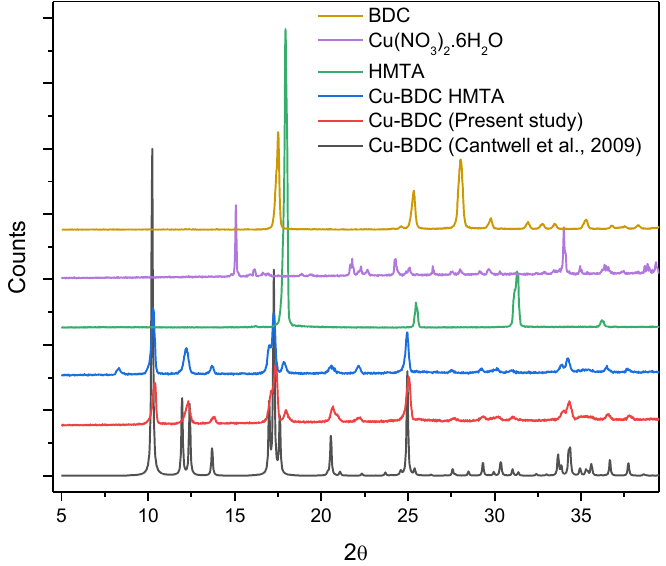
Figure 2. PXRD patterns for Cu-BDC (black, reported by Carson et al., 2009), Cu-BDC (red, synthesized herein), Cu-BDC ⊃ HMTA (blue), HMTA (green), Cu(NO 3 ) 2 · 6H 2 O (lilac) and the H 2 BDC linker (dark yellow).